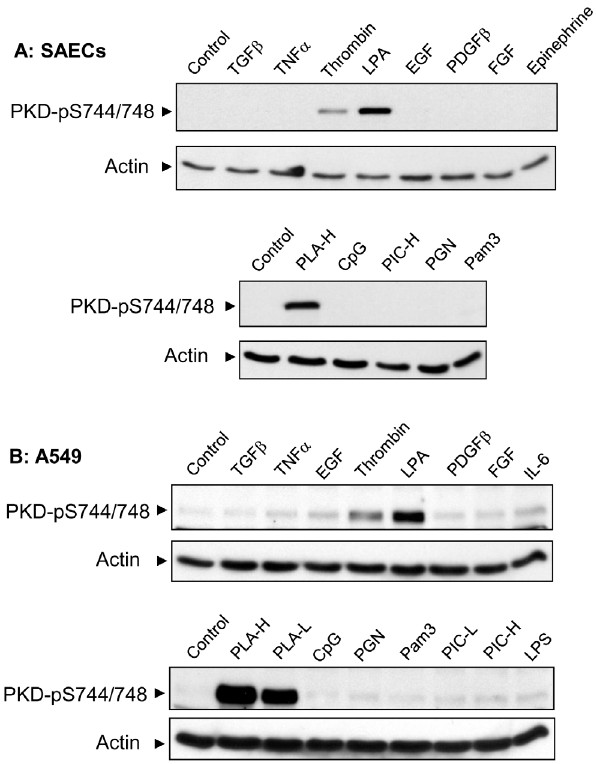
Figure 7. PKD promotes lung epithelial barrier permeability in the presence or absence of co-cultured primary lung fibro- blasts or endothelial cells. A: pooled 16HBE14o- cells stably expressing control GFP or GFP-PKD3 as described [22] were grown on Transwell inserts in DMEM medium supplemented with 7.5% FBS in the presence or absence of co-cultured primary human lung fibroblasts derived from IPF lungs (99A and 110A) and normal subjects (131N and 13N) in the bottom chamber. TEER (Ohm 6 cm 2 ) was measured on day 6 using an EVOMX voltohmmeter. B: pooled 16HBE14o- cells stably expressing control GFP or GFP-PKD3 were grown on Transwell inserts in EGM-2 medium with or without co-cultured HPAECs in the bottom chamber and TEER was measured on day 5. All data are means 6 S.E. (n=3). *, p , 0.05; **, p , 0.01 versus control GFP control cells. Similar results were obtained in three independent